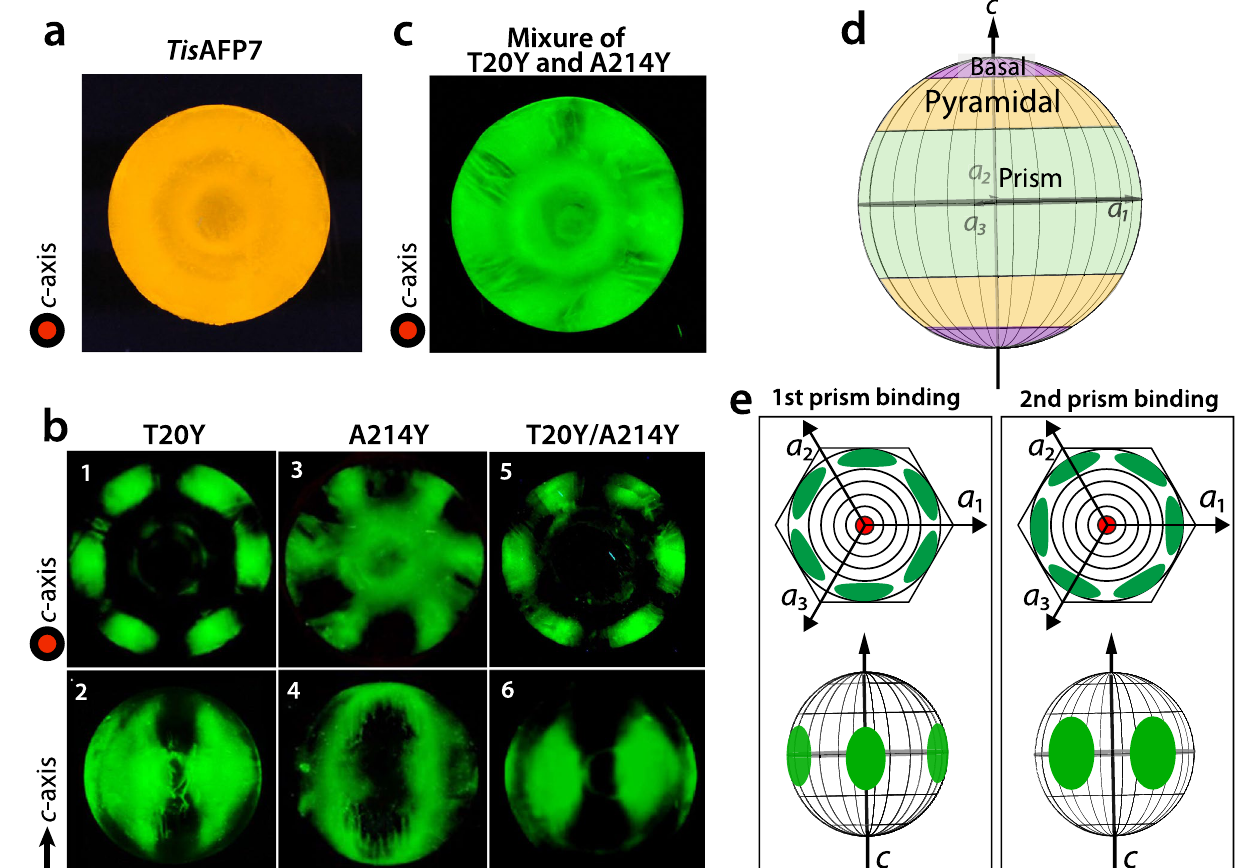
Figure 2. Ice plane specificity of wild-type Tis AFP7 and its mutants, as determined by FIPA analysis. The concentration of protein solution was 0.007 mg/ml in all experiments. ( a ) Fluorescence image of a single ice- crystal hemisphere grown in a solution of wild-type Tis AFP7 labeled with an orange fluorescent dye. The single ice crystal was mounted on the cold finger perpendicular to the basal plane. The c -axis direction of the ice crystal is shown in the figure as a circle. ( b ) Fluorescence from single ice-crystal hemispheres grown in solutions of Tis AFP7 T20Y, A214Y, and T20Y/A214Y mutants labeled with a green fluorescent dye. Upper panels, the hemispheres were mounted in the same orientation as in ( a ); lower panels, the hemispheres were mounted with a primary prism plane perpendicular to the cold finger. The c -axis direction is shown as an arrow. ( c ) A single ice crystal grown in the solution containing equal concentrations of T20Y and A214Y mutants (0.0035 mg/ ml of each). ( d ) Schematic illustration of ice planes mapped onto a hemispherical-shaped ice crystal. The polar regions correspond to the ice basal plane. The equator and middle latitude zones correspond to the prism and pyramidal planes, respectively. ( e ) Schematic illustrations of fluorescent patches corresponding to the primary and secondary prism planes on the ice hemisphere in known orientation. When the ice crystal is mounted with the basal plane perpendicular to the cold finger, the primary (1st) prism plane appears between the a 1 -, a 2 -, and a 3 -axes with a hexagonal symmetry, as shown by the upper images. The secondary (2nd) prism plane is situated on the region pierced with the a 1 -, a 2 -, and a 3 -axes. When the ice crystal is mounted with the primary prism plane perpendicular to the cold finger, three patches are observed on the equator of the hemisphere for the primary prism plane, whereas two patches are seen for the secondary prism the seed ice crystal (Fig. 5c, panel 1). At the moment of freezing, the ice crystal rapidly grew in two directions along the c -axis (Fig. 5c, panel 2). A similar growth pattern was observed for wild-type Tis AFP7 at a low protein concentration (0.01 mM, Fig. 1b, panels 3 and 4) and Tis AFP6 (Fig. 1b, panels 9 and 10), which suggested that the T20Y substitution reduced the protein’s ability to bind the basal plane. In the case of the A214Y mutant, the ice crystal was modified to form a rounded hexagonal plate below T m (Fig. 5c, panel 3) and expanded maintain- ing this shape (Fig. 5c, panel 4). Hence, the A214Y mutant retained the affinity for the basal plane. The TH of a double T20Y/A214Y mutant was lower than those of single mutants, and the mutant exhibited an impaired ice-growth inhibition (Fig. 5c, panels 5 and 6). On the other hand, a mixture of equal concentrations of the two single mutants recovered the TH to 68% that of the wild type (Fig. 5b). Furthermore, ice morphology in the mixture was the same as that for wild-type Tis AFP7 (Fig. 5c, panels 7 and 8). Next, the single mutants T20Y and A214Y, and double mutant T20Y/A214Y were fluorescently labeled and subjected to FIPA analysis (Fig. 2b, panels 1, 3, and 5). The samples were mounted on the cold finger in the